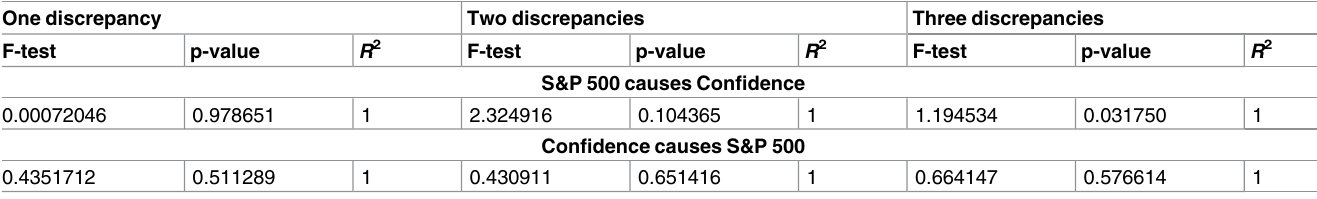
Table 10. Granger test results—causality relationship between the S&P 500 index and its respective confidence index. One discrepancy